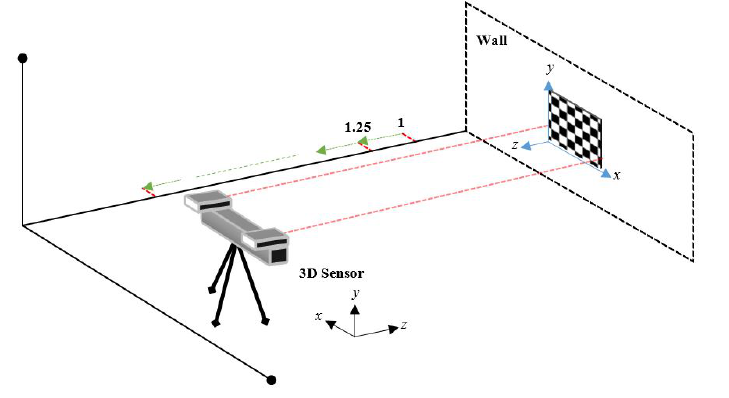
Figure 1. Data acquisition